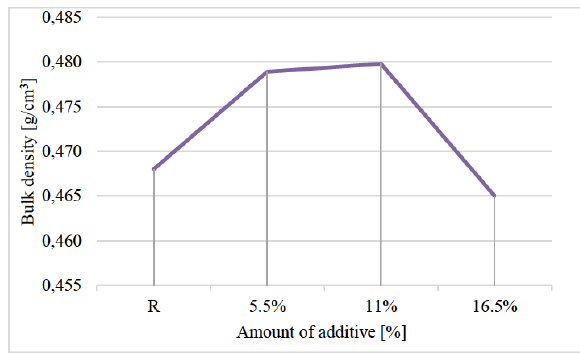
Figure 8: Results of volumetric density of sand-lime products with the use of used casting compounds.